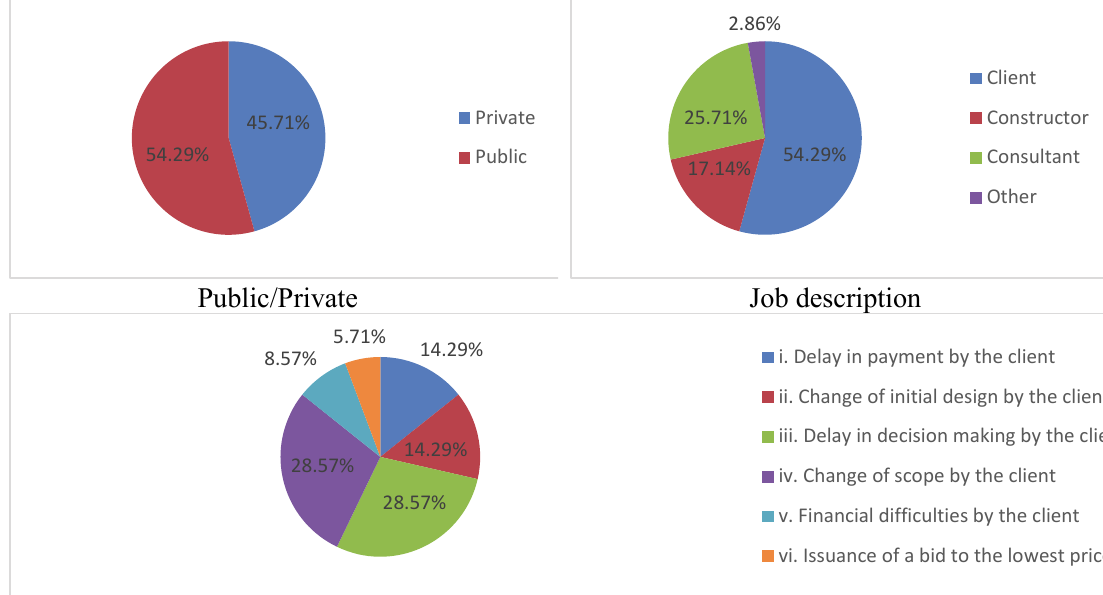
Fig. 2. Characteristics of the project managers, their job description and client related cases of de- lay in accomplishment of